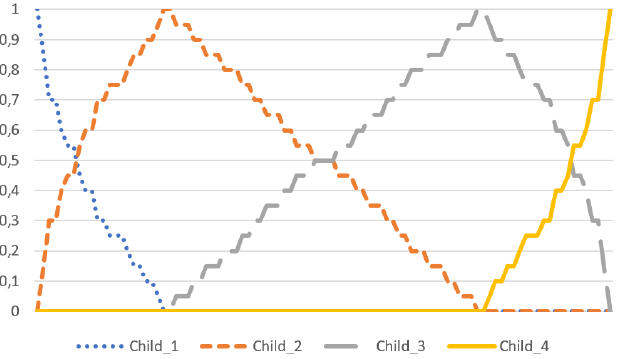
Figure 6. Weighted Diagonal: the probability per child state, given the ordening of the parents states on the